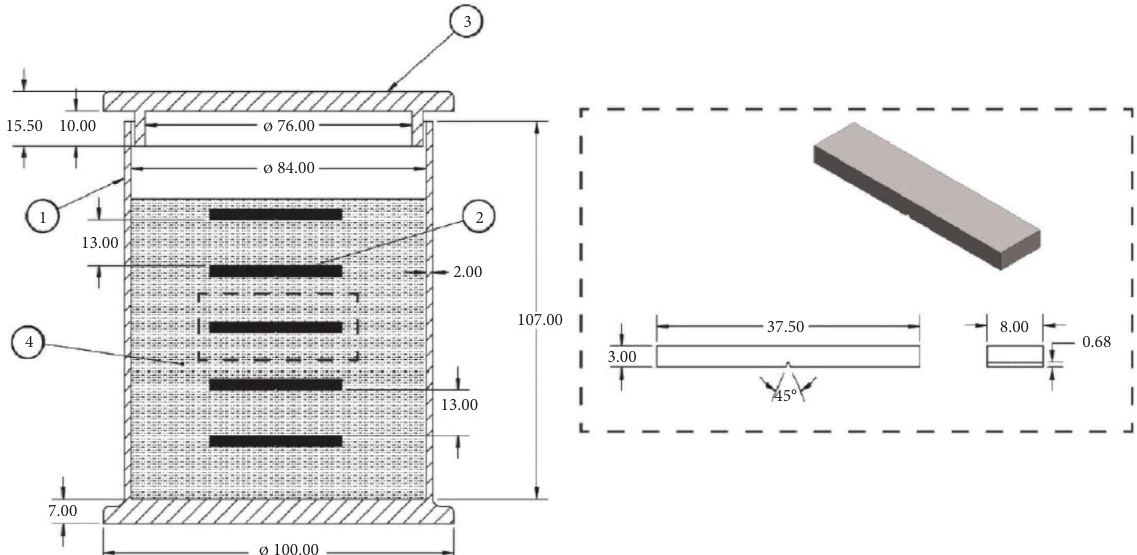
Figure 1: Schematic view of the dehydrated paste pack boriding process:1-container, 2-specimen (dimensional details in the rectangle area in mm), 3-lid, and 4-dehydrated boron paste.